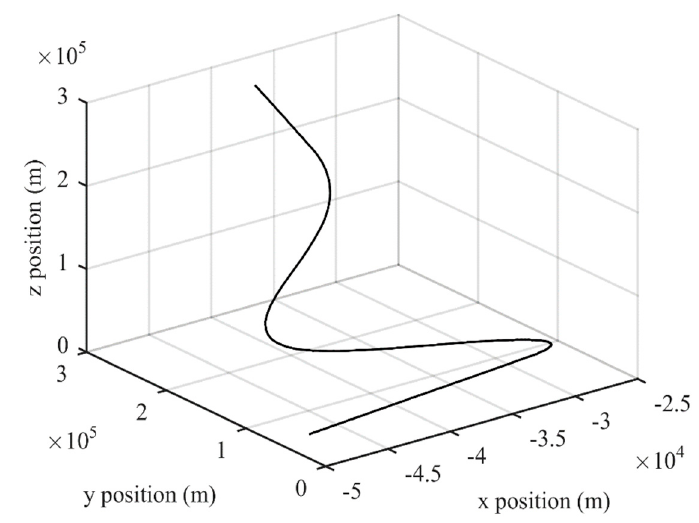
Figure 5. Real trajectory of a high-maneuvering target.